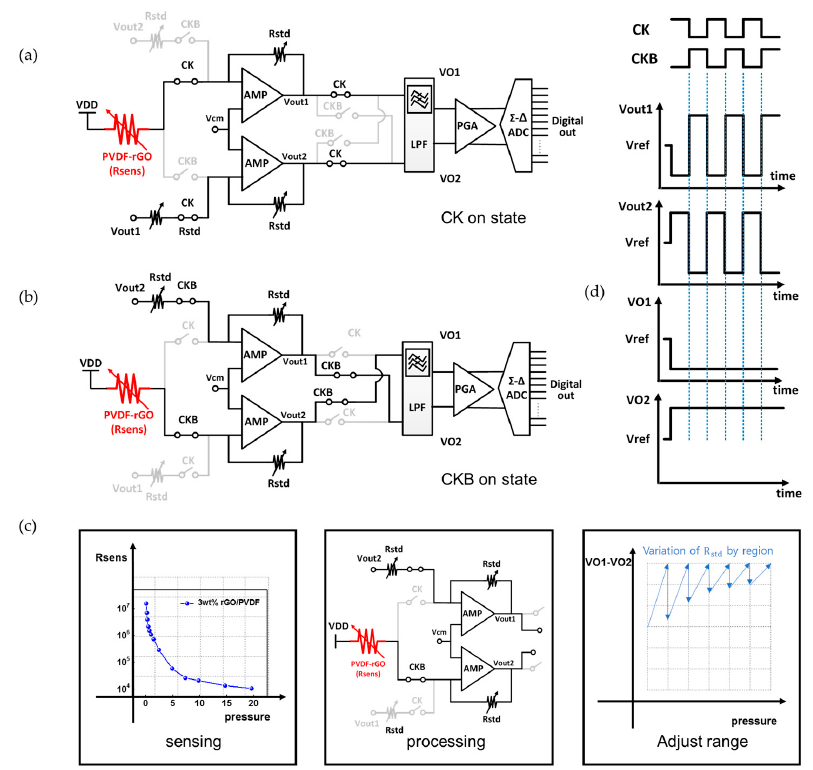
Figure 4. Detailed circuit operation of P mode for static pressures: ( a ) active path when CK is on state; ( b ) active path when CKB on state; ( c ) linearization process; and ( d ) transient node voltages.